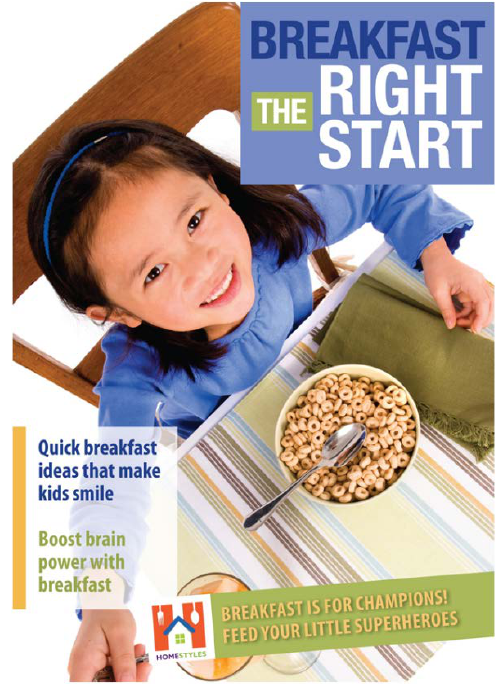
Figure 1. Example guide showing cover lines.